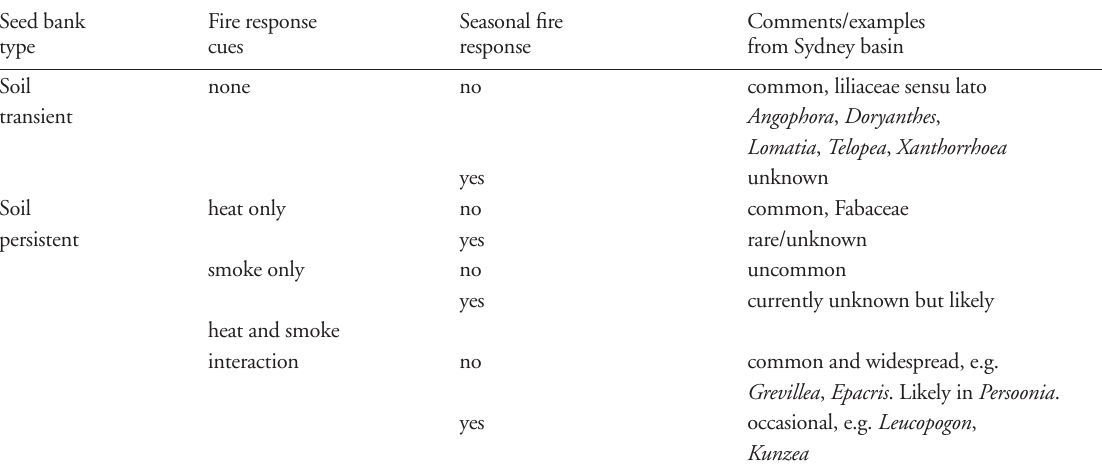
Table 2. Incorporation of fire related seed germination strategies into a functional classification of plants. This level of classification would sit below the distinction between persistent and transient seed banks under each of the seeder and sprouter categories. Seed bank type